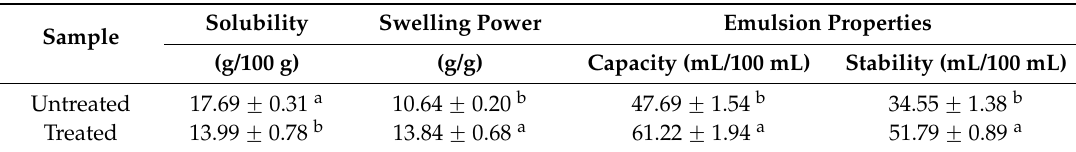
Table 5. Solubility, swelling power and emulsion properties of untreated and alkali-treated defatted rambutan seed flours.